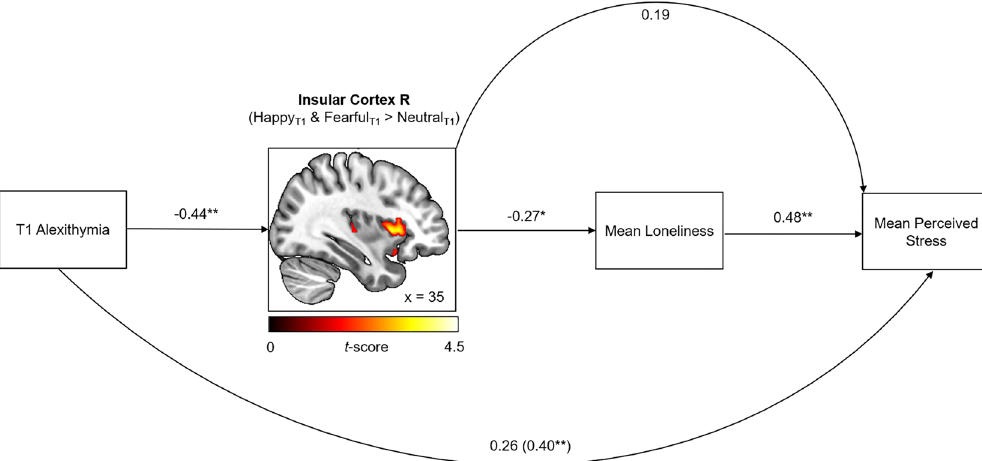
Figure 3. Mean loneliness mediated the relationship between alexithymia at study entry and mean perceived stress ratings. Furthermore, activation of the right insula in response to emotional stimuli at study entry mediated the link between alexithymia and loneliness. Numbers show standardized β coefficients. The β coefficient in brackets shows the total effect without mediators. Insula coordinates are shown in Montreal Neurological Institute space. For illustration purpose, the cluster is shown with a significance level of p = 0.05. * p < 0.05, ** p < 0.01, T1 study entry, R